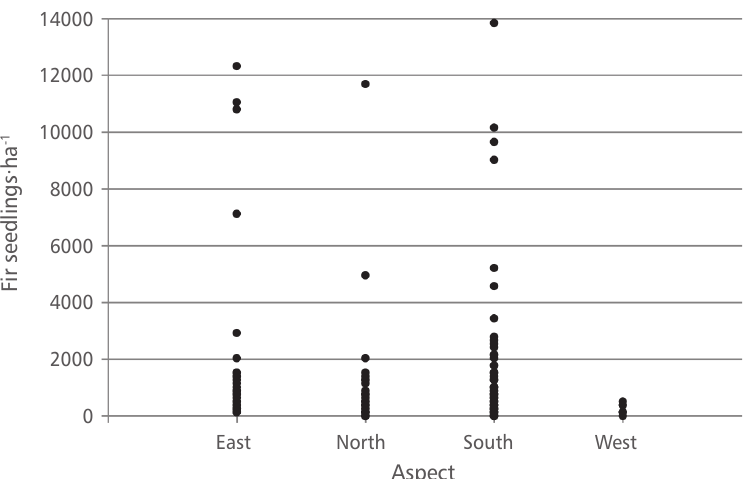
FIGURE 4. Fir seedling densities observed at different aspects. Dots represent individual values.